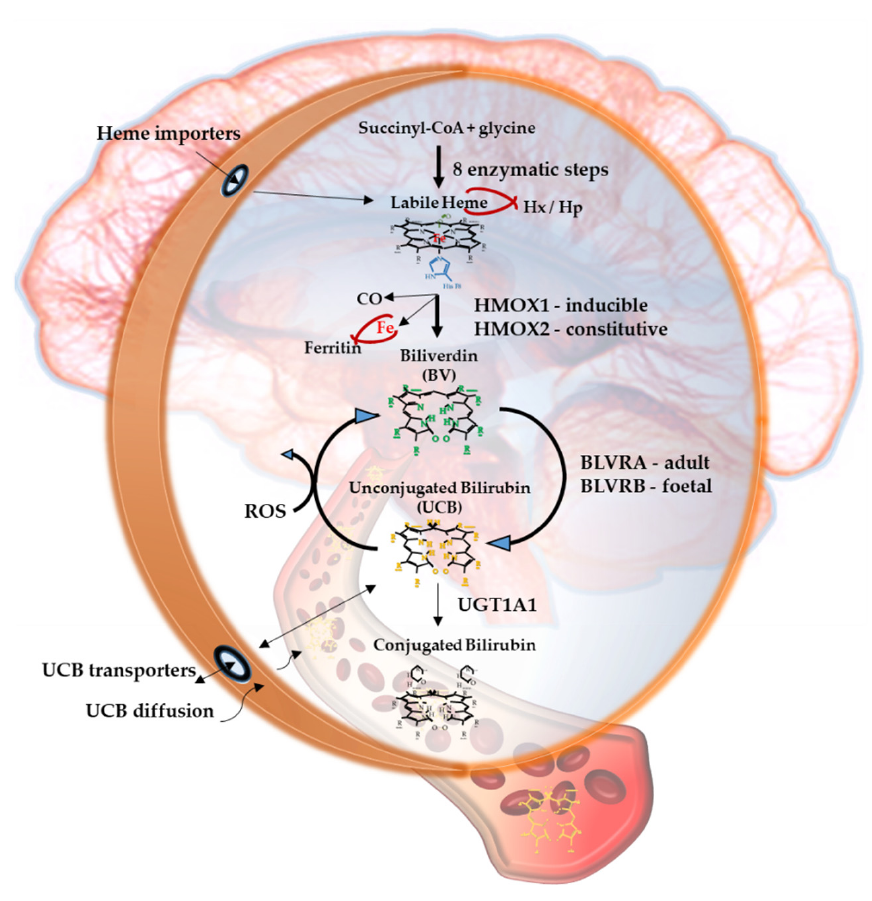
Figure 1. The yellow players.